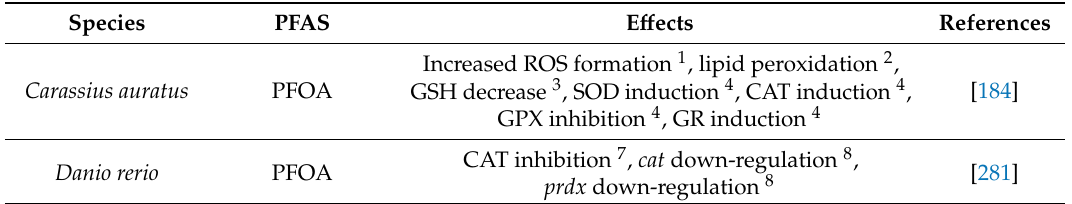
Table 2. PFAS e ff ects on human and other